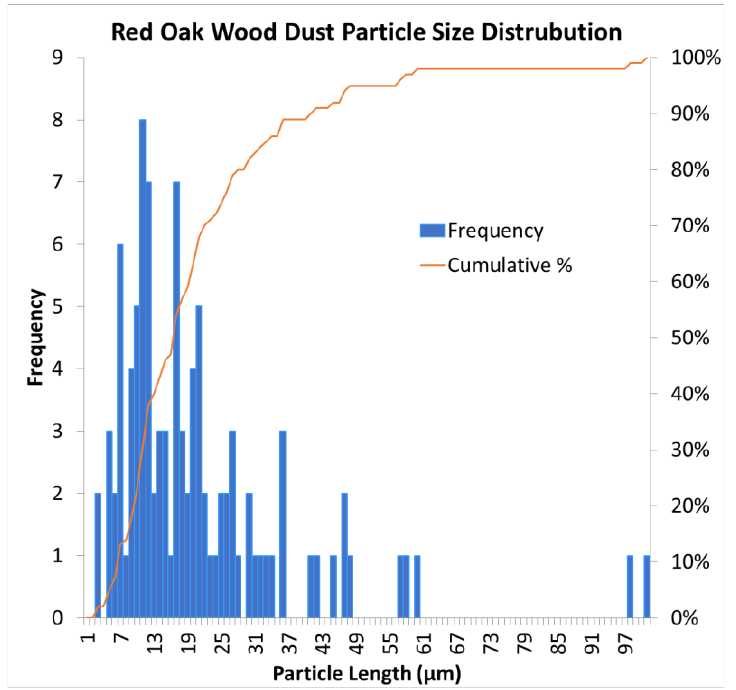
Figure 10. Red oak wood dust particle size distribution ( n = 100 particles). Blue bars indicate frequency of each particle length, and the orange line indicates cumulative percentage.